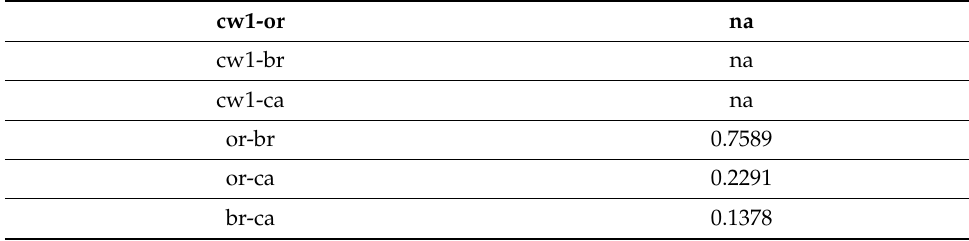
Table 6. The new MIS based on the generalized aggregation method (Equation (3)).